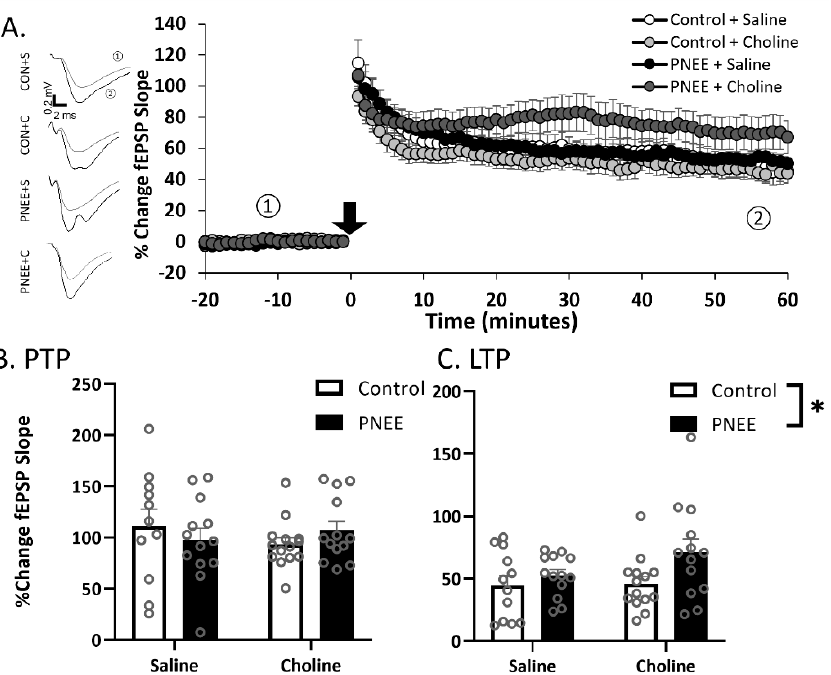
Figure 5. Increased LTP in juvenile female offspring following PNEE. ( A ) Average LTP for each condition. Each point represents four traces binned to the one-minute interval. The black arrow represents the HFS conditioning stimulus. Representative traces are featured above for ① pre-conditioning and ② post-conditioning. Control + saline = white, control + choline = light grey, PNEE + saline = black, and PNEE + choline = dark grey. Average PTP (( B ); first minute following HFS) and LTP (( C ); minutes 50–60 following HFS) for each condition. * Represents p < 0.05. Error bars are ±